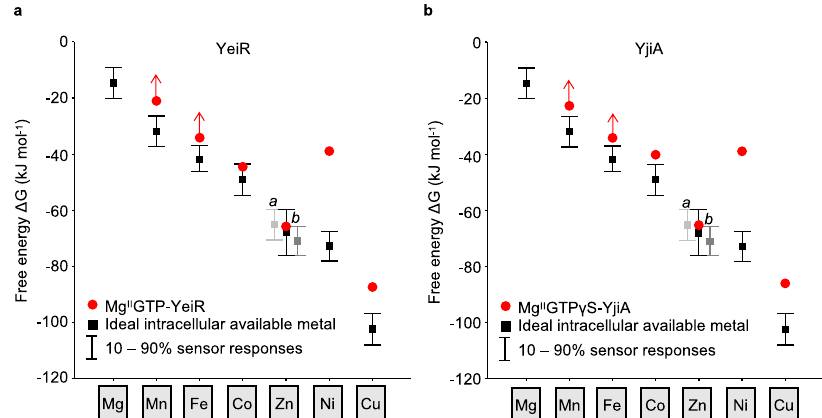
Fig. 6 Mg II GTP-YeiR and Mg II GTP-YjiA preferentially acquire Zn II . a Free-energy change ( Δ G ) for metal binding to Mg II GTP-YeiR (red circles) plotted against the intracellular available free energies for metal binding (as described in Fig. 5; black squares and bars). b As a for Mg II GTP γ S-YjiA (red circles). Arrows indicate where only a limiting Δ G was determined (thus Δ G > plotted